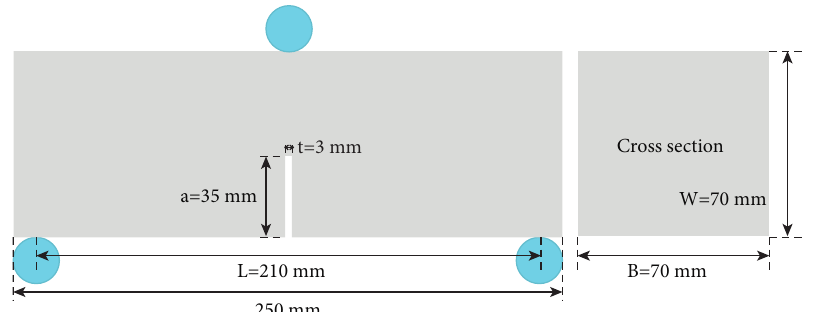
Figure 5: Dimensions of the tested frozen specimen for three-point bending test.